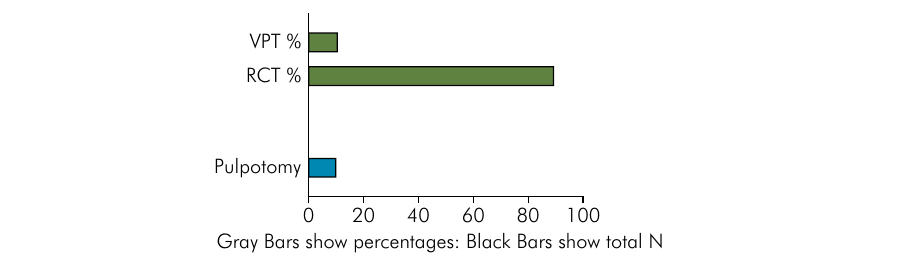
Figure. Clinical and radiographic images provided to participants for cases 1(A), 2(B), 3(C), and 4(D) and vital pulp therapy (VPT) and root canal treatment (RCT) indication rates and total N of VPT indications for the seven clinical cases of the study